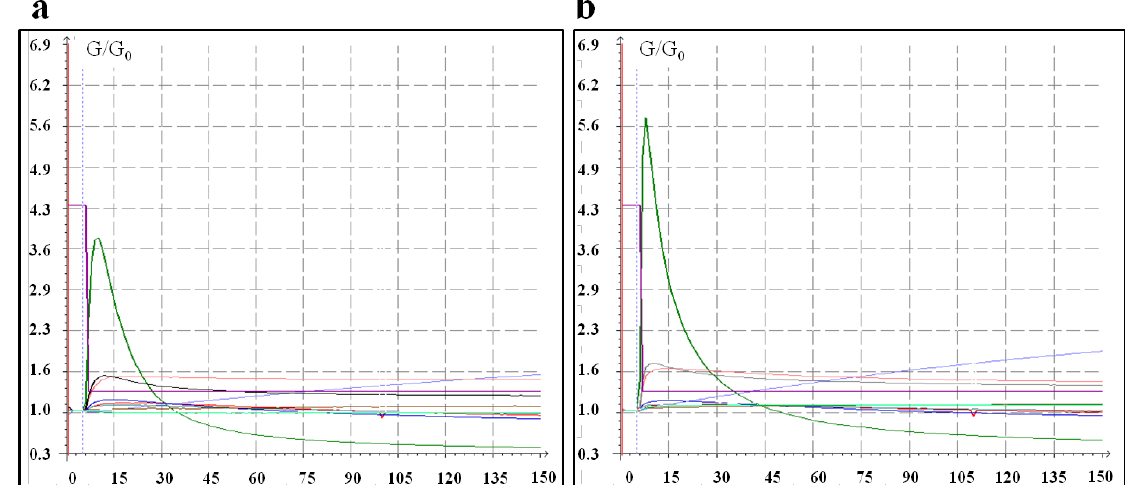
Figure 1. Representative sensor patterns of a negative sample pretreated at two different desorption temperatures. X-axis: Changes of conductance expressed as G/G Measurement duration (150 s). (a) desorption temperature: 180 °C; (b) desorption temperature: 200